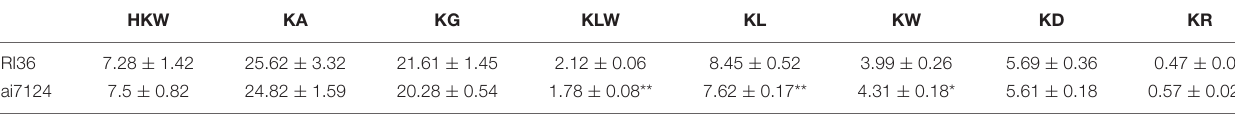
TABLE 1 | Comparison of the seed size and shape-related traits between two parents Gossyium hirsutum CRI36 and G. barbadense Hai7124. HKW KA